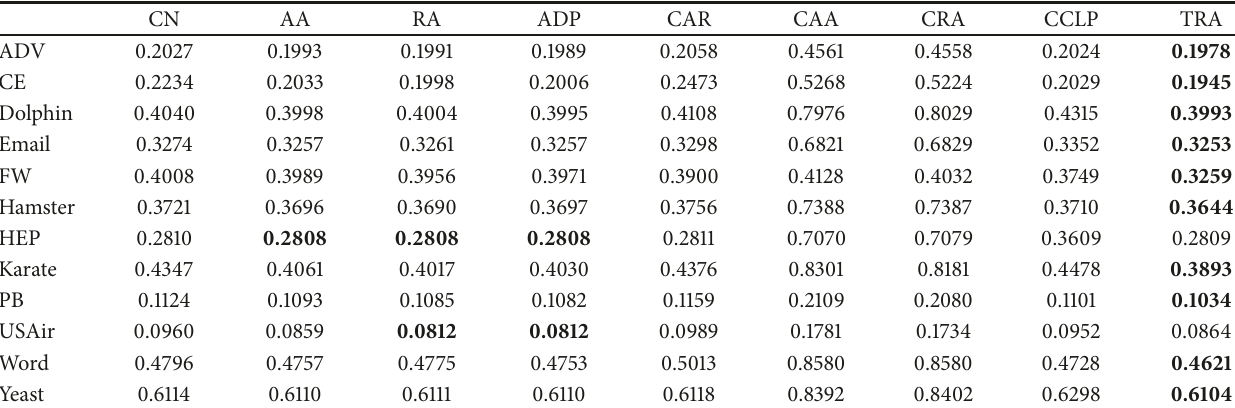
Table6:Therankingscoreofdifferentmethodsin12networks.Theresultsaretheaverageof50independentimplementationswith |𝐸 𝑡𝑠 |/|𝐸| = 0.2 . The best performance for each network is emphasized by